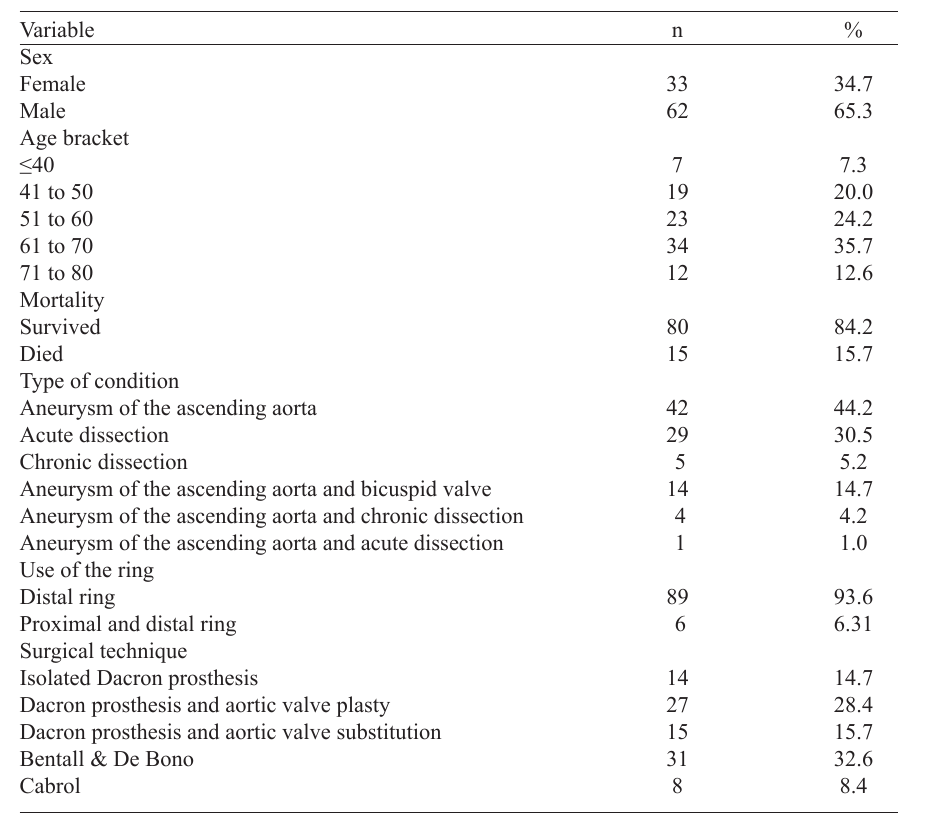
Table 2. Demographic, clinical and surgical variables of the 95 patients submitted to surgery of the ascending aorta at Madre Tereza Hospital (Belo Horizonte, MG, Brazil), from 2008 to